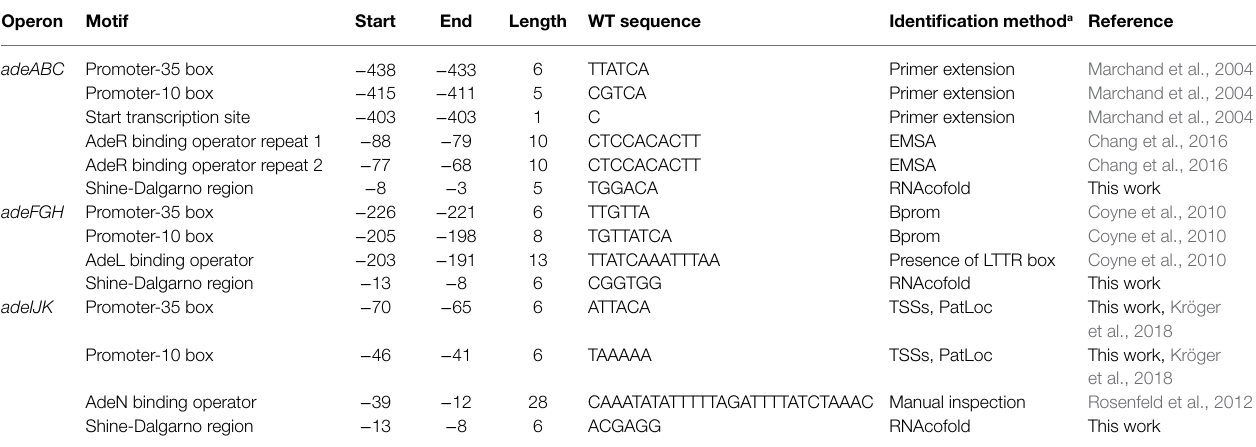
TABLE 2 | Upstream motifs associated to RND pump